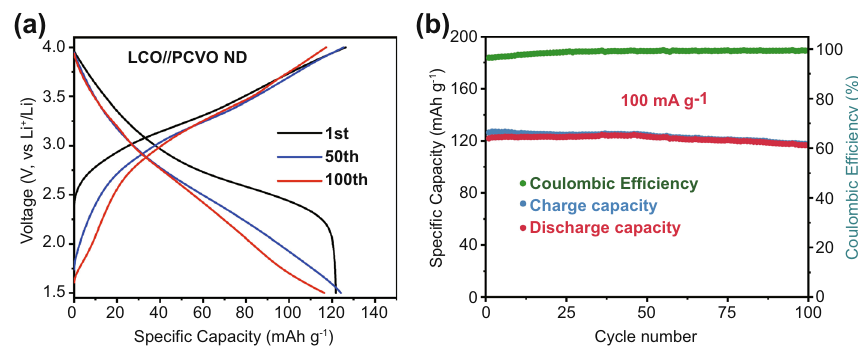
Fig. 6 a Galvanostatic charge/discharge curves for the 1st, 50th, and 100th cycles at a current density of 100 mA g −1 over the potential range of 1.5–4.0 V. b Cycling performance of the LiCoO 2 // PCVO ND full cell at a current density of 100 mA g